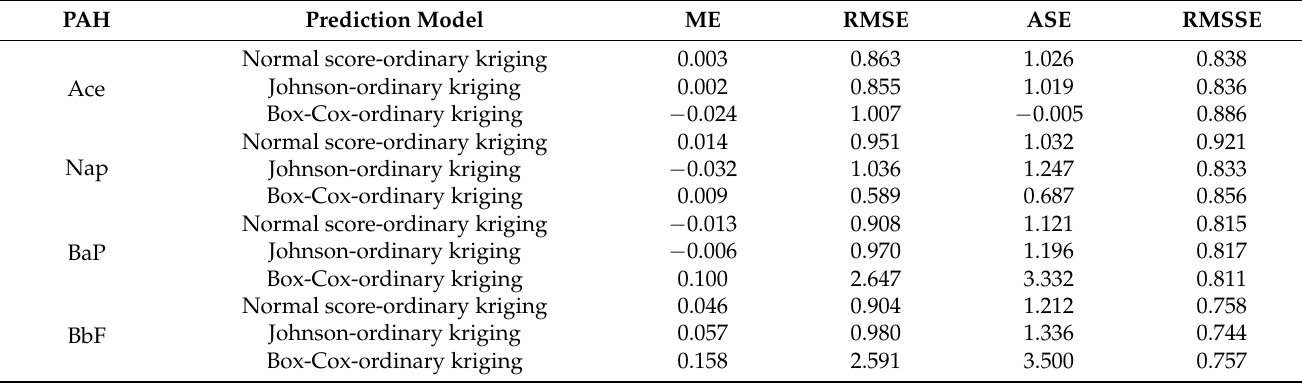
Table 4. Cross-validation indices for different data transformation